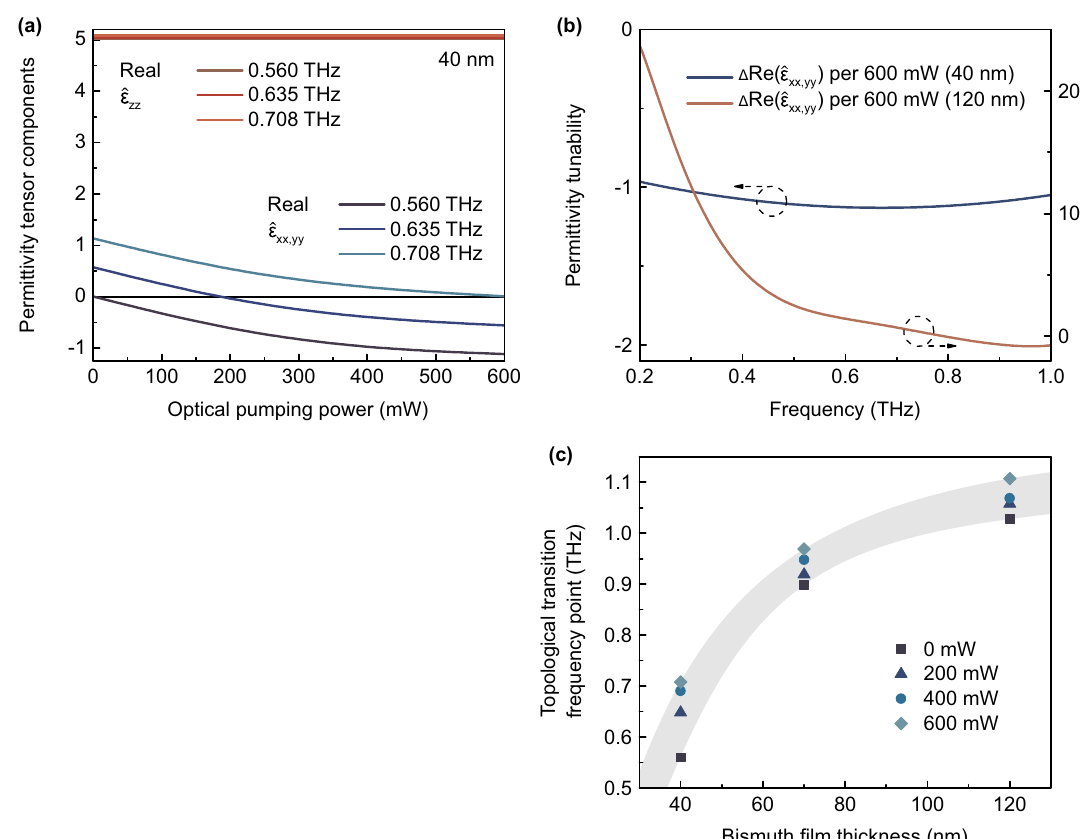
Figure 6. Results of experiment (tunable parameters). ( a ) Dependency of the real part of permittivity tensor components (40 nm Bi) on the optical pumping power for different frequencies of THz radiation. ( b ) The frequency-dependent tunability of Re ( ˆ ε xx , yy ) in the case of 40 and 120 nm Bi-based structures under influence of optical pumping with a maximum investigated power of 600 mW (7.5 mW/mm 2 ). ( c ) The dependency of topological transition frequency point (where Re ( ˆ ε xx , yy ) = 0 ) on bismuth film thickness (at a fixed mica thickness of 21 µm) for different optical pumping power values. The points on the graph correspond to the experimental values, and the highlighted area displays the assumed behavior according to the nonlinear dependence of bismuth dielectric permittivity on its thickness and THz radiation frequency. The points added for 70 nm Bi films are obtained on the basis of additional experiment with data presented in Supplementary